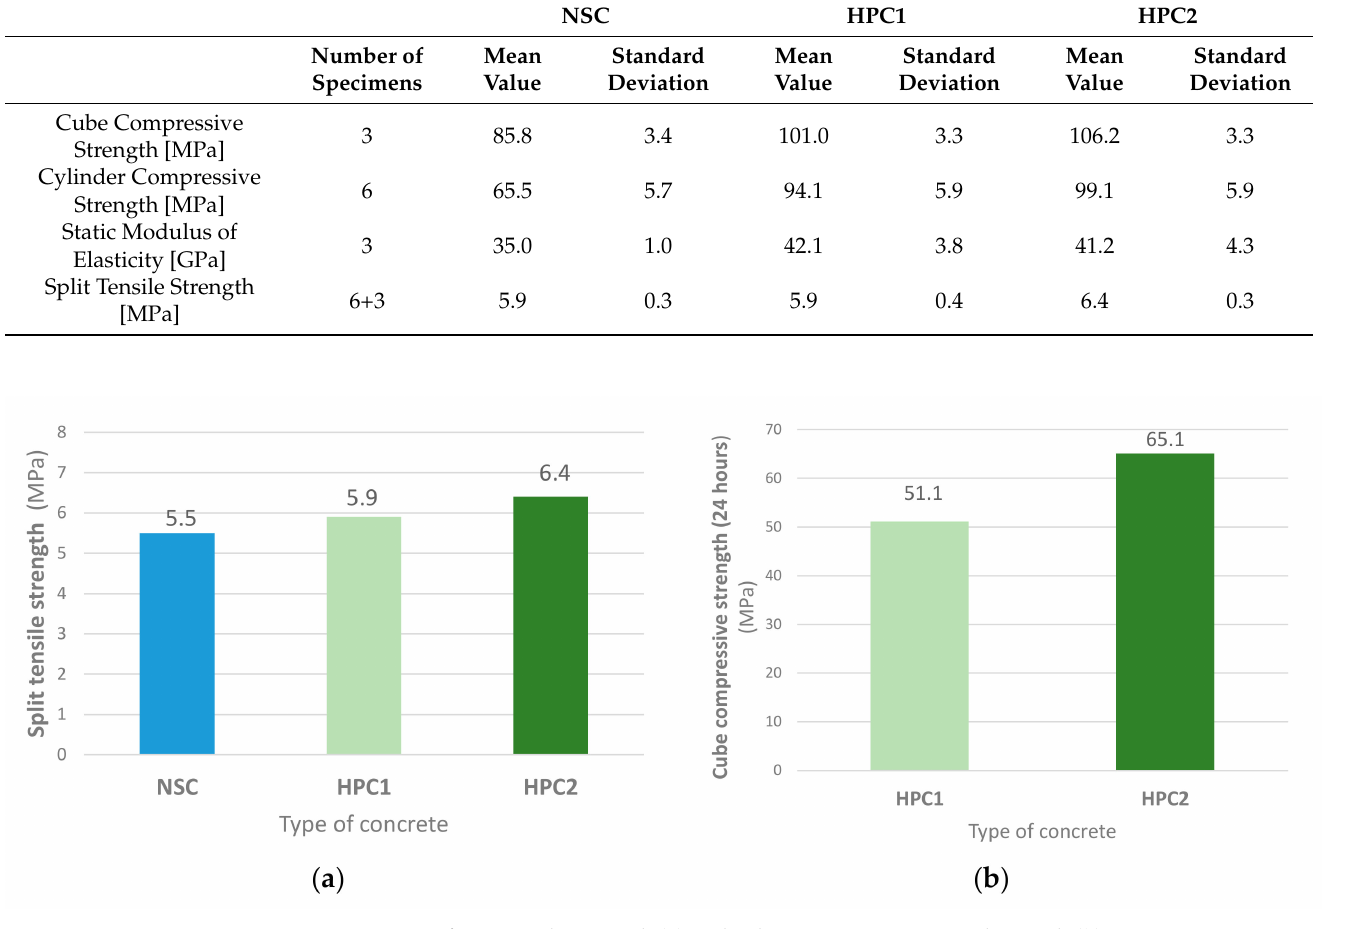
Figure 3. Comparison of spit tensile strength ( a ) and cube compressive strength in 24 h ( b ).